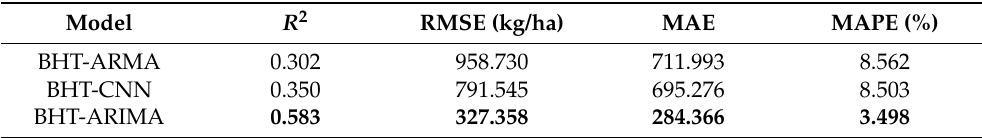
Figure 10. The R 2 , RSME, MAE, and MAPE for the relationship between the observed and predicted yields for the ( a ) BHT-ARMA, ( b ) BHT-CNN, and ( c ) BHT-ARIMA models. The dashed line is the 1:1 line. Since these tensorized models specify non-zero input values, the models have only 10 sets of output values after automatically eliminating the unreasonable values. Table 6. The R 2 , RSME, MAE, and MAPE of predictions using the BHT-ARMA, BHT-CNN, and BHT-ARIMA models.